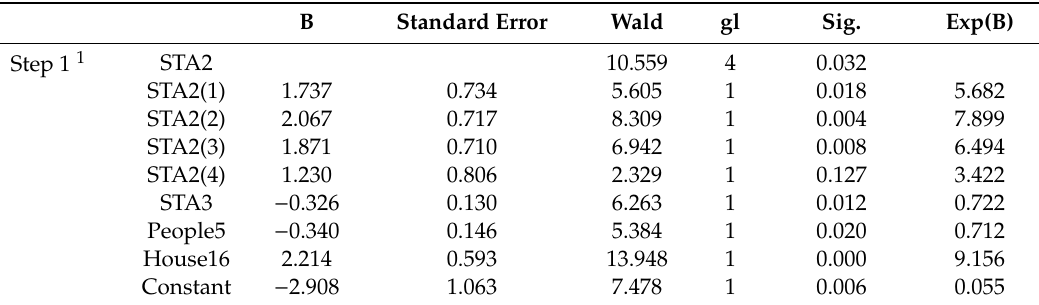
Table 1. Variables in the